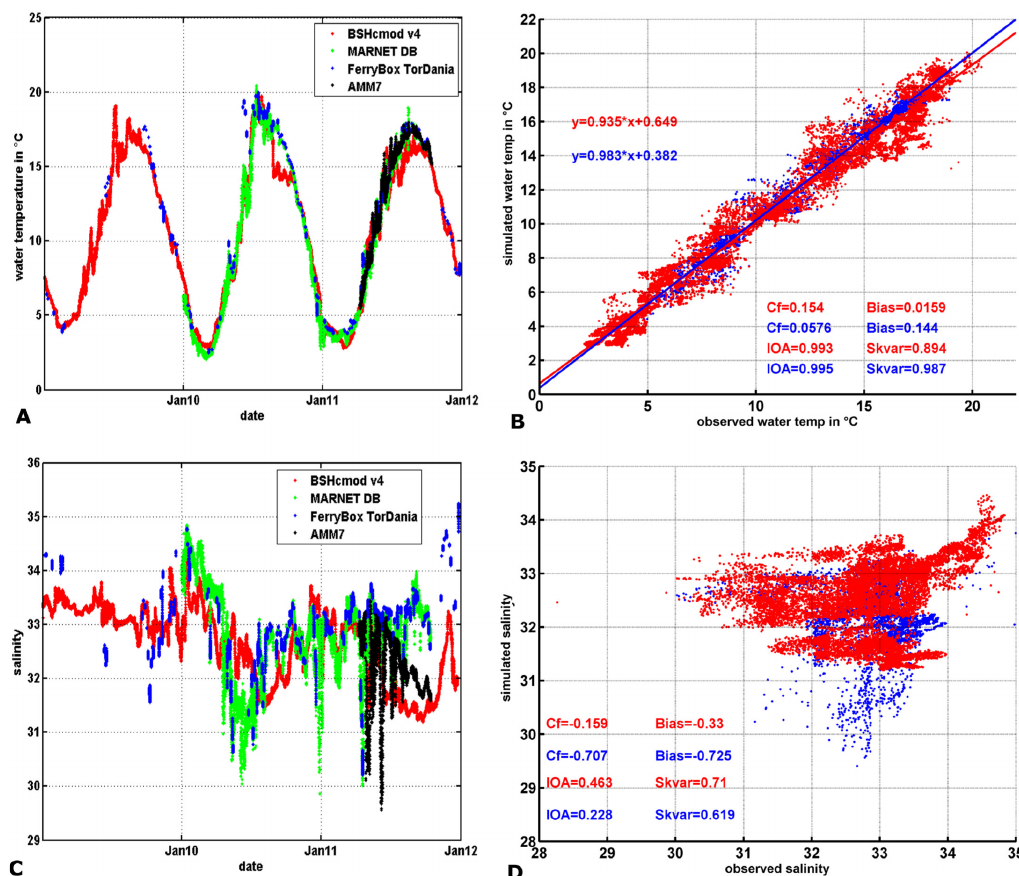
Figure 11. Upper panels: time series (a) and scattering (b) of water temperatures of FerryBox observations, BSHcmod v4 and AMM7 at the German Bight (p3). In Fig. 11a, red dots denote BSHcmod v4, blue AMM7. Lower panels: time series of salinity of FerryBox observations, BSHcmod v4 and AMM7 at the German Bight (p3) (c) and scatterplot of salinity (d) . In Fig. 11d, red dots denote BSHcmod v4, blue